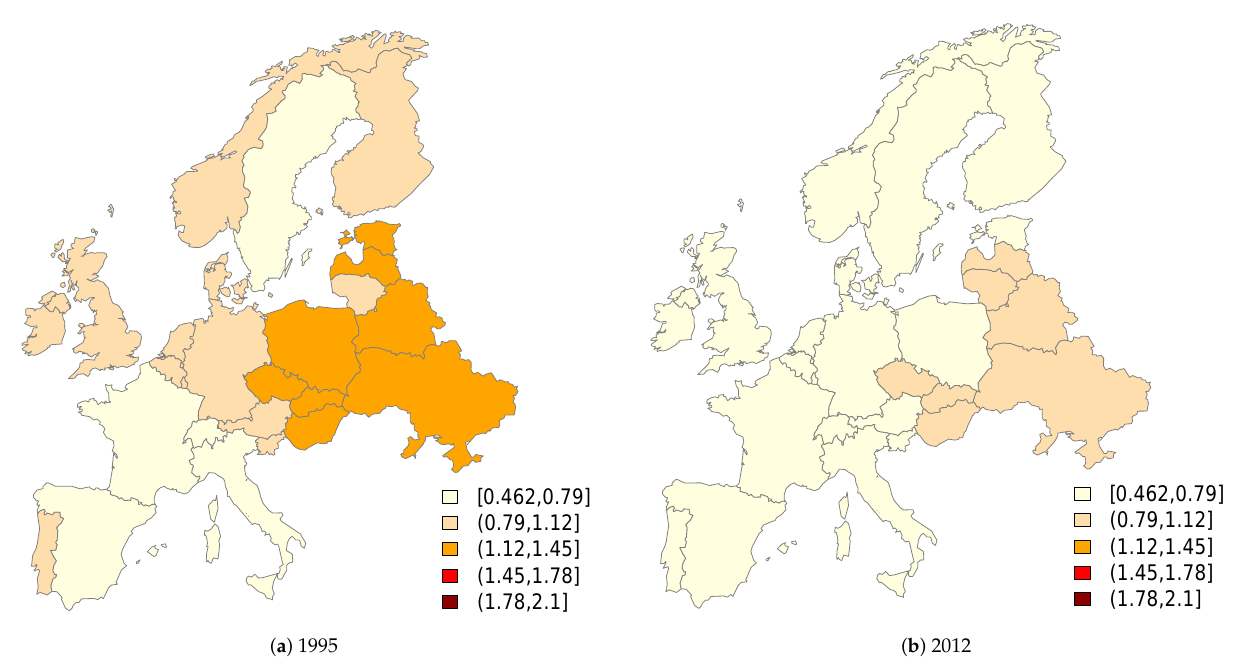
Figure 2. CMF in Europe for 1995 and 2012 for females.